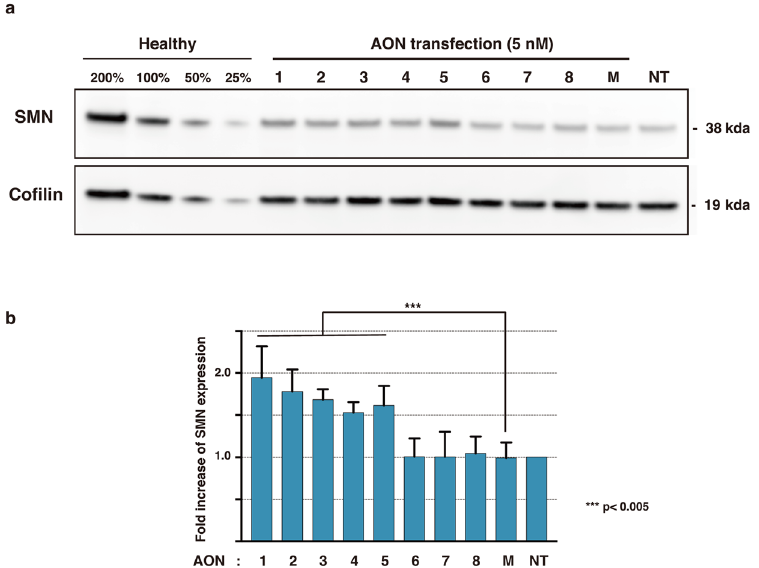
Figure 4. Transfection of the novel LNA/DNA mixmers increases the production of SMN protein. ( a ) Western blotting of SMN and Cofilin of healthy and AON-treated SMA patient fibroblasts (GM03813). ( b ) Fold increase in SMN expression of AON-treated SMA patient fibroblasts. 5 nM transfection of AON 1–5 significantly increased the production of SMN proteins. Cofilin was used as a loading control. The data was normalized to the ratio of SMN/Cofilin in non-treated SMA fibroblasts. Bars represent mean ± S.D. of four